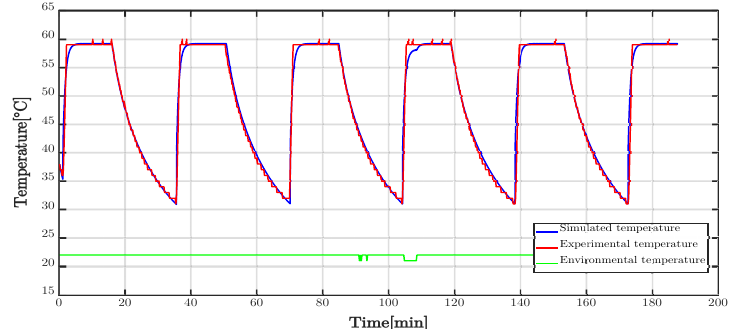
Figure 12. Experimental and simulated results for a single thermal zone.